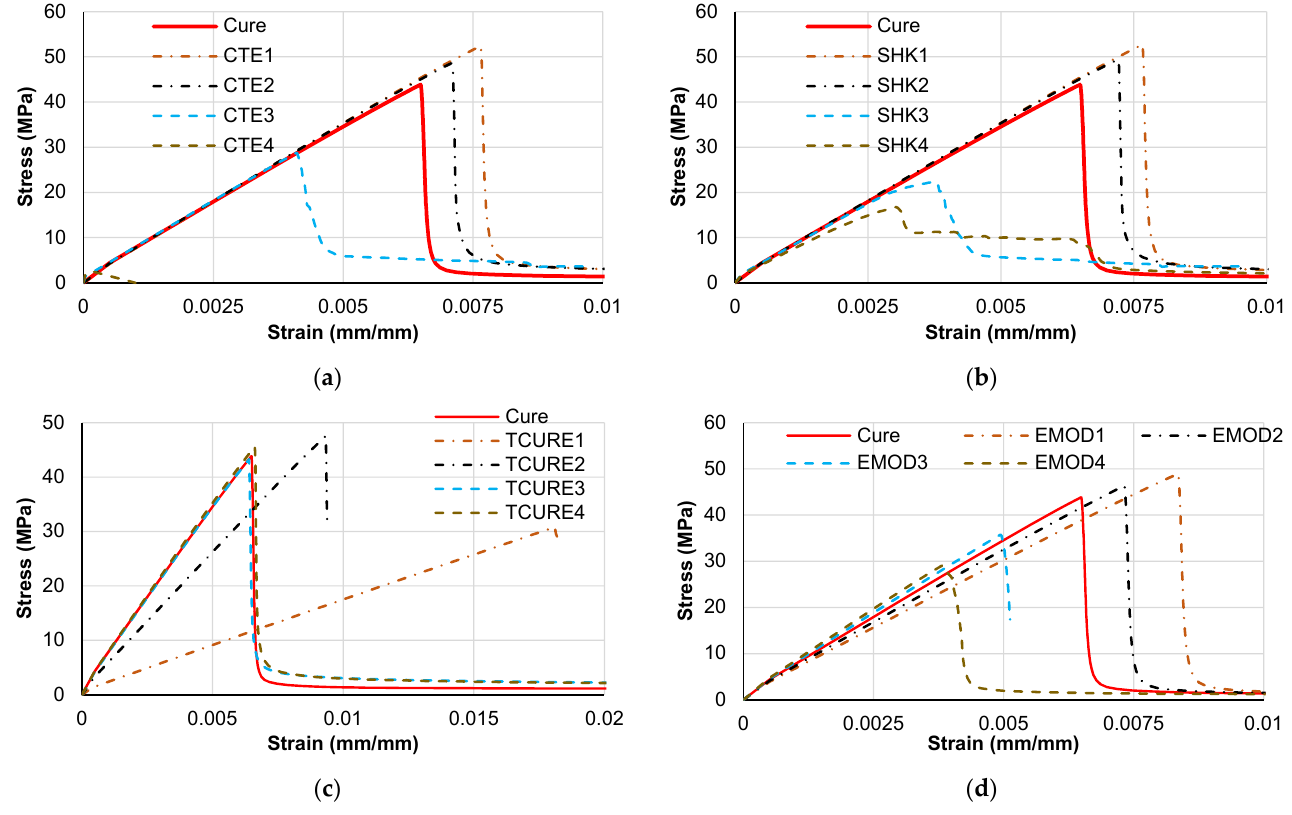
Figure 17. Tensile stress–strain response sensitivity to material and process parameters. ( a ) Ther- mal expansion sensitivity results, ( b ) Chemical shrinkage sensitivity results, ( c ) Cure temperature sensitivity results and ( d ) Elastic modulus sensitivity results.